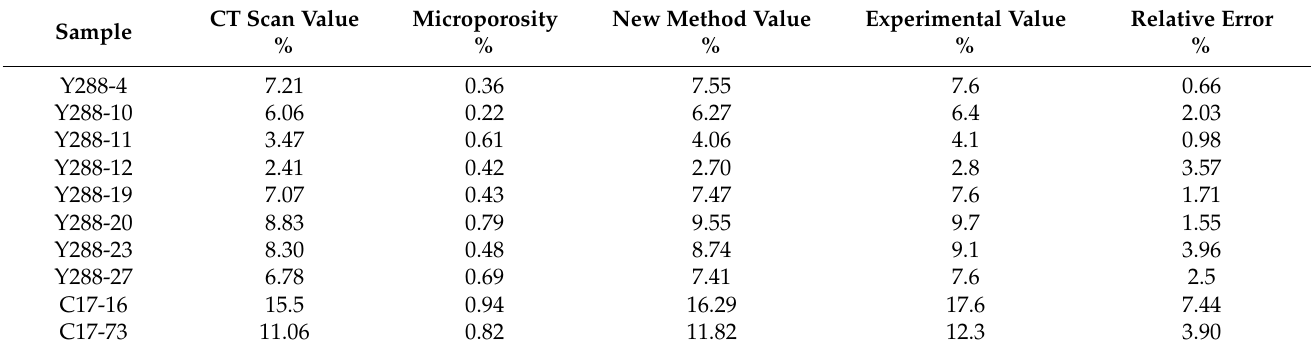
Table 1. Porosity comparison between digital core with complex pore structure and experimental value.